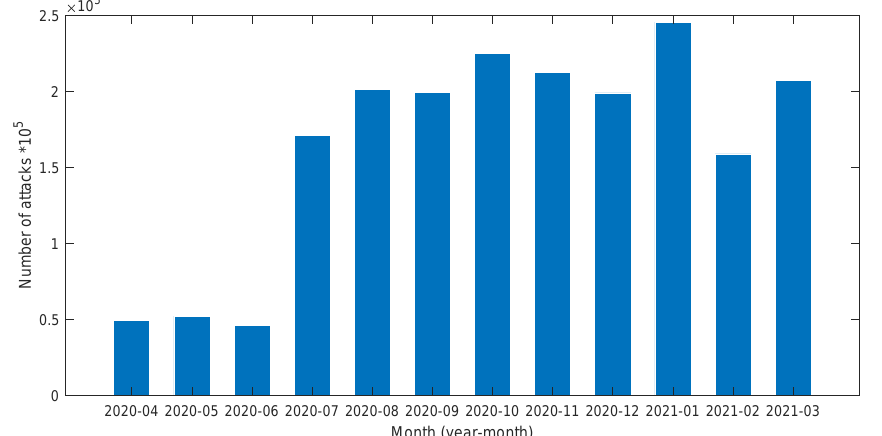
Figure 1. Trend of phishing